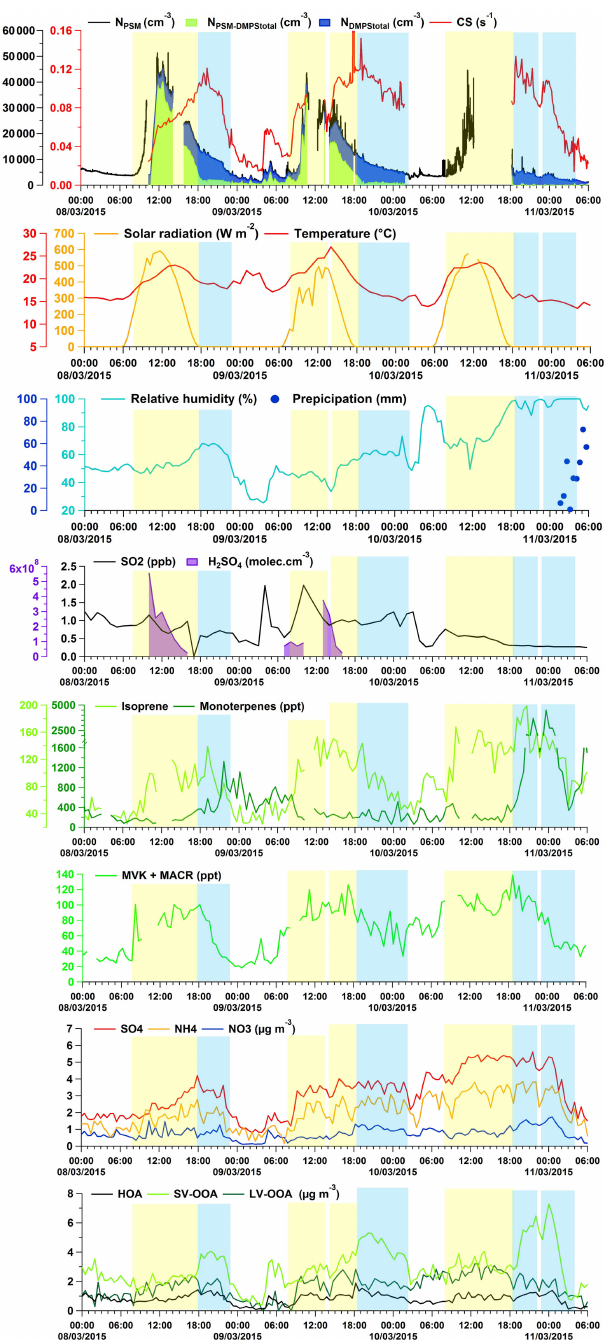
Figure 11. Time series of N PSM , N DMPS , N PSM − DMPS and CS during NPF2 event days (i.e., 8–10 March) in comparison to me- teorological parameters (global solar radiation, temperature, rela- tive humidity and precipitation), SO 2 , H 2 SO 4 , BVOCs (isoprene, MVK + MACR and monoterpenes) and PM 1 composition. Time is given in local time (UTC + 2h). NPF events are represented in yellow and nighttime succeeding NPF events are depicted in blue. These periods are discussed in Sect.